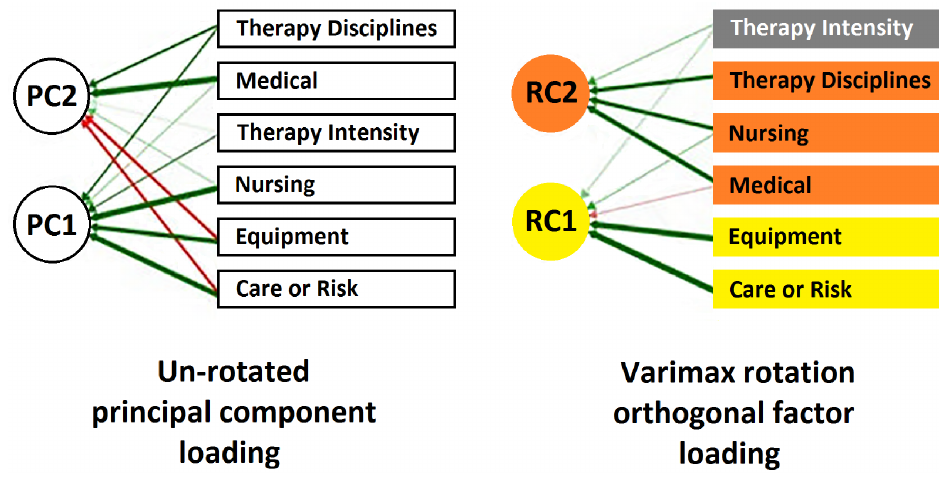
Fig 2. Path diagram of the confirmatory factor analysis of the RCS-E